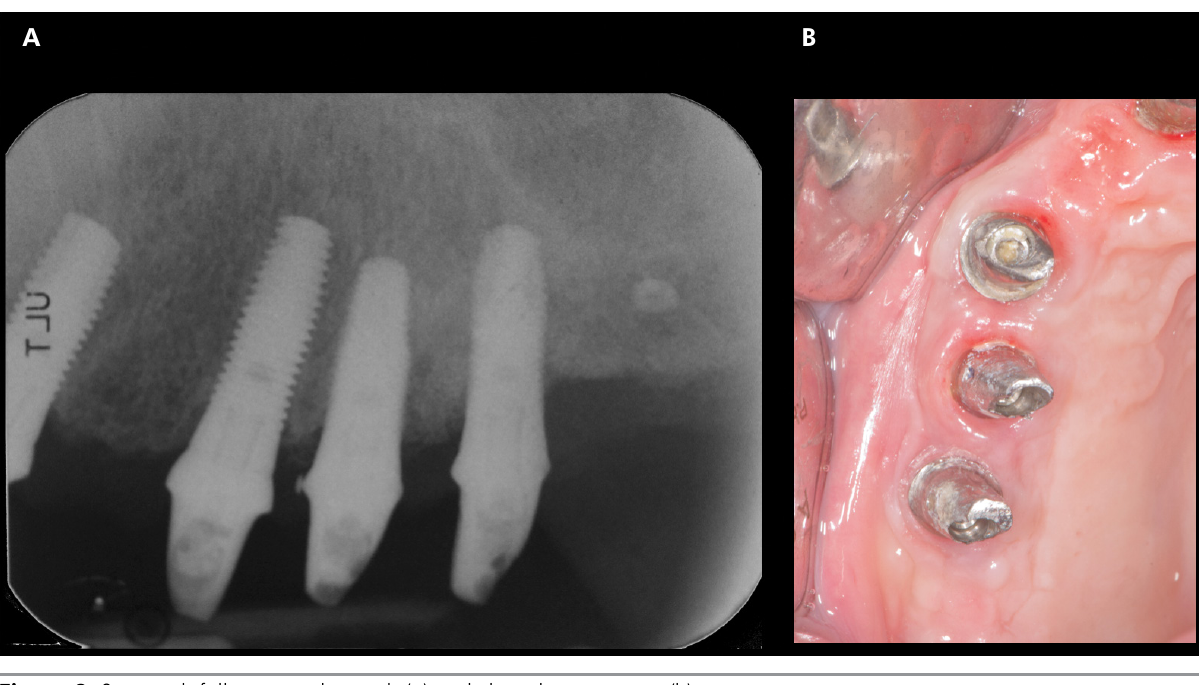
Figure 3. Six-month follow-up radiograph (a) and clinical appearance (b).